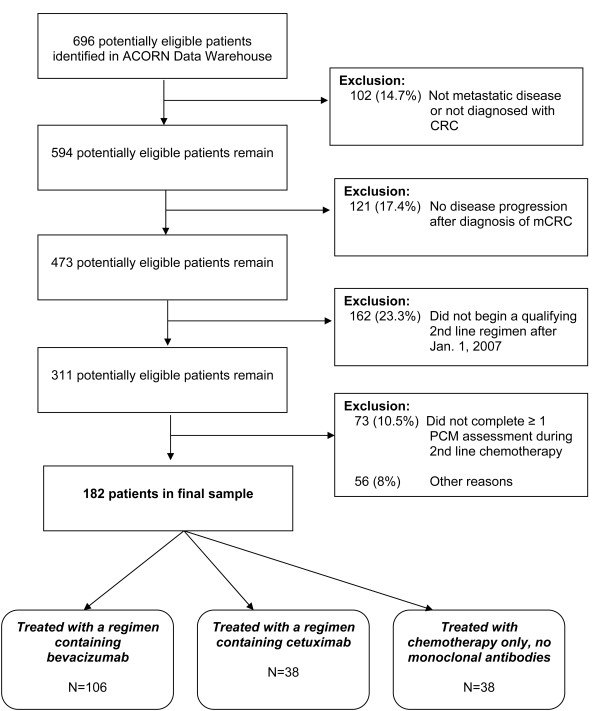
 Sample development.